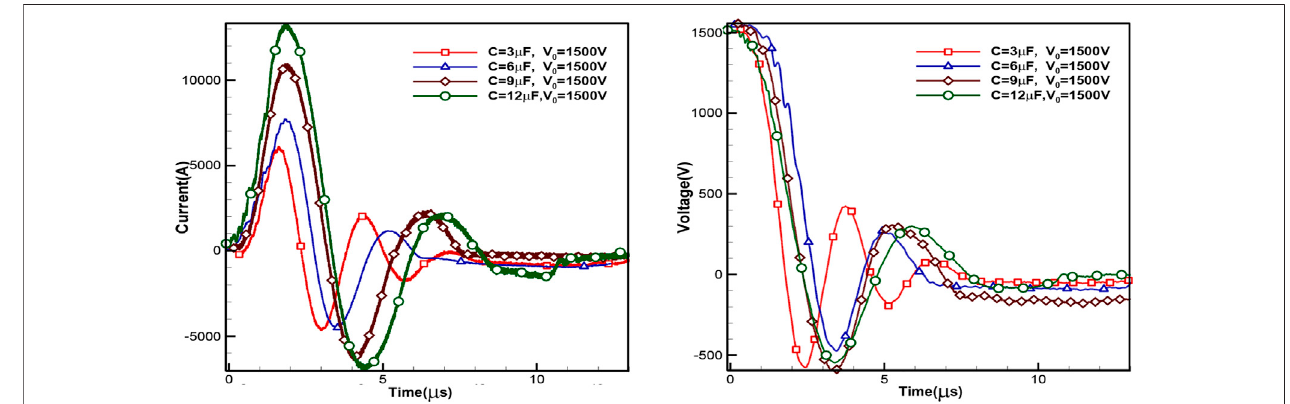
FIGURE 6 | Discharge waveforms of APPT at different capacitances.